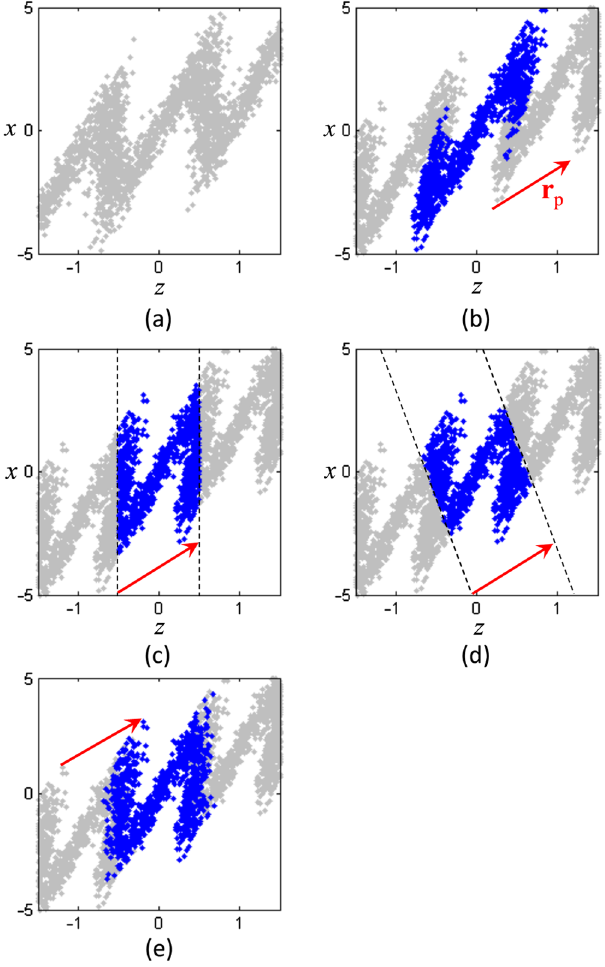
FIG. 1. Periodic particle distributions and periodic shift vector r : (a) pseudoperiodic random distribution with periodic behav- p ior; (b) generating set S and periodically repeated particles in p blue resp. gray; (c) equivalent generating set in slice volume between two planes shifted by r ; (d) other equivalent set in p different volume slice; (e) equivalent generating set without sharp